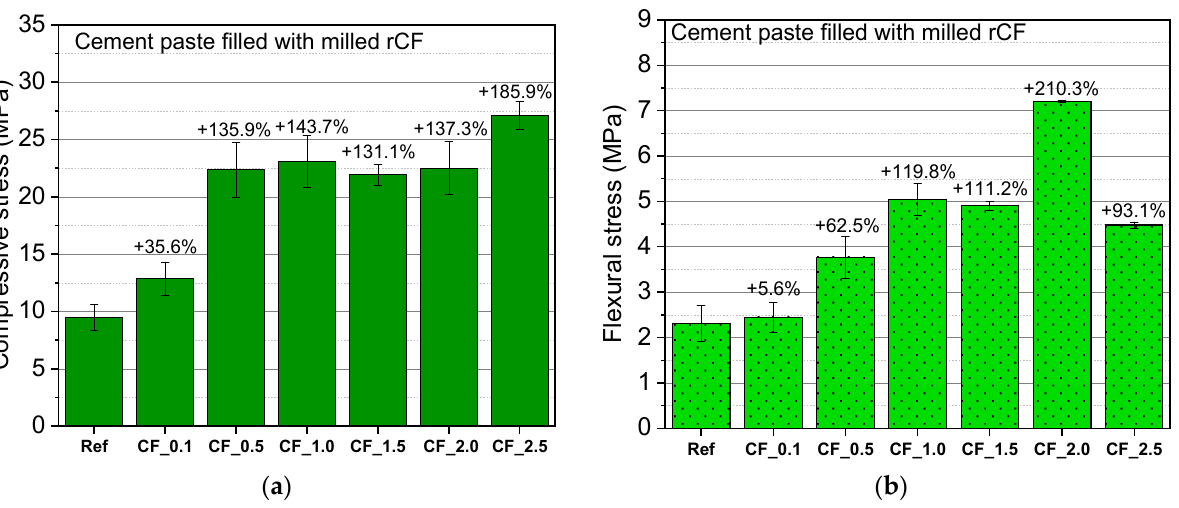
Figure 10. Average ( a ) compressive strength and ( b ) flexural strength of cement composites with milled rCFs at 28d.